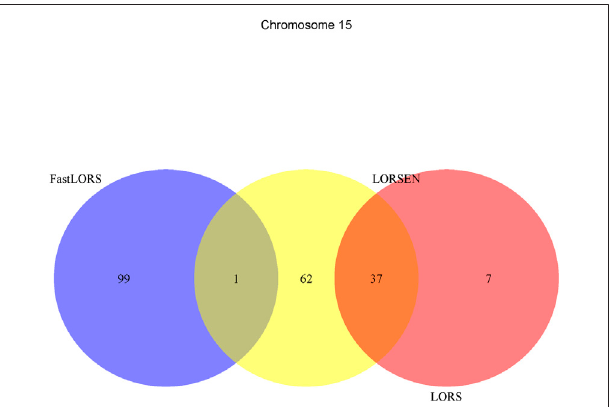
FIGURE 2 | The top 100 SNP-probe pairs identi fi ed by FastLORS, LORSEN, and LORS on Chromosome 15.